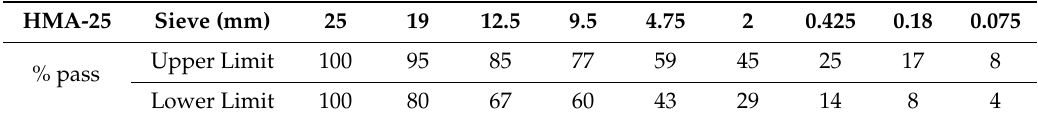
Table 3. Distribution size of HMA-25 [36].